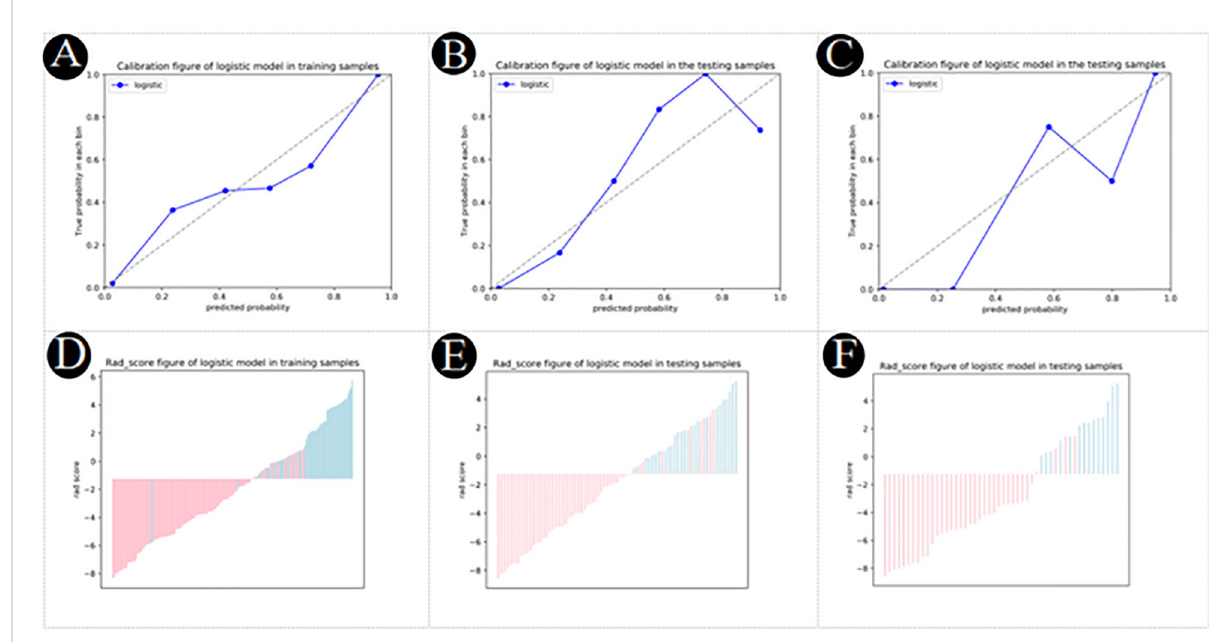
FIGURE 7 (A – C) Calibration plot of logistic model for PM-SCLC in the training cohort, the internal validation cohort, the external validation cohort, respectively. (D – F) Rad score plot of logistic model for PM-SCLC in the training cohort, the internal validation cohort, the external validation cohort,